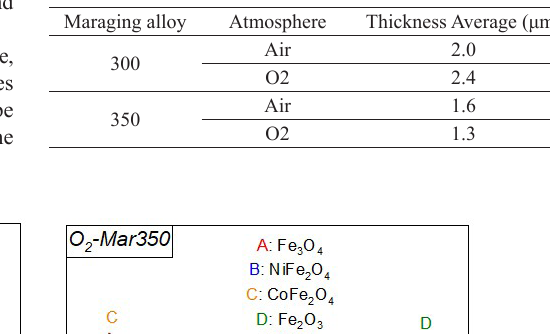
Table 8. Average thickness measured from the FE-SEM micrographs for the oxide produced by each